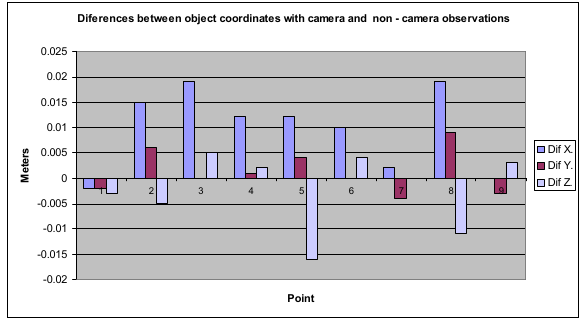
Figure 7. Differences between object coordinates in long range distance test with camera and non cameras observations.